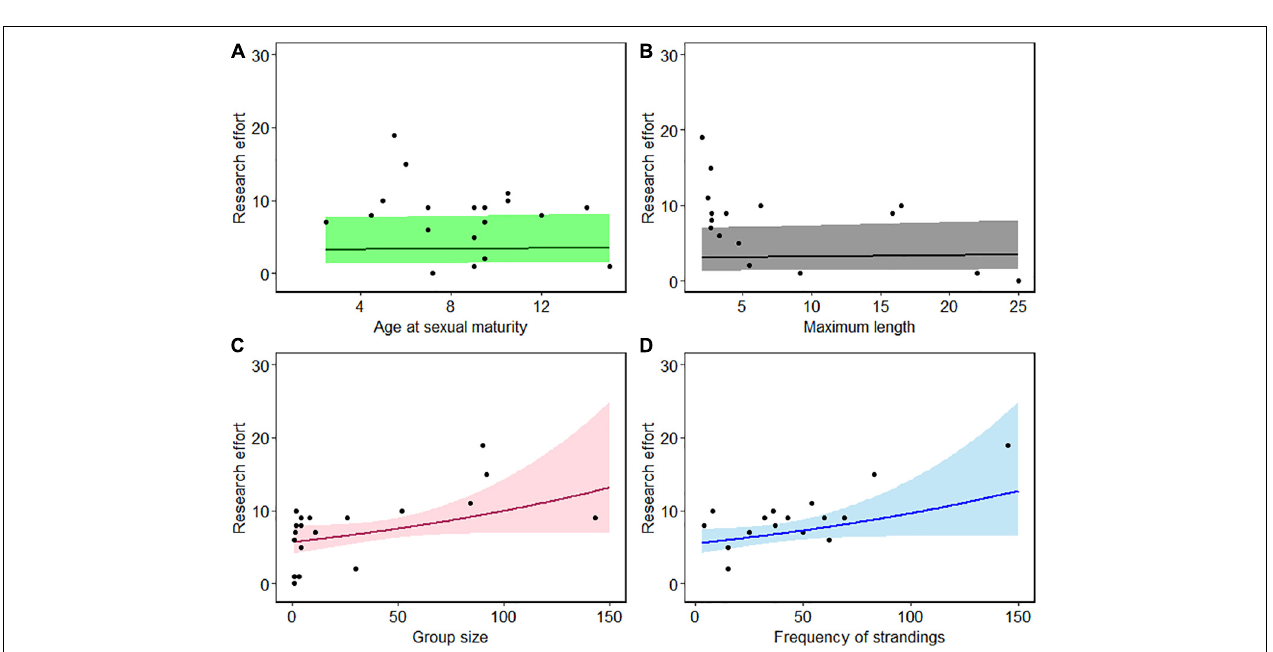
FIGURE 5 | Mean fitted number of publications with 95% confidence interval against (A) age at sexual maturity (years), (B) maximum length (m), (C) gregariousness, and (D) stranding